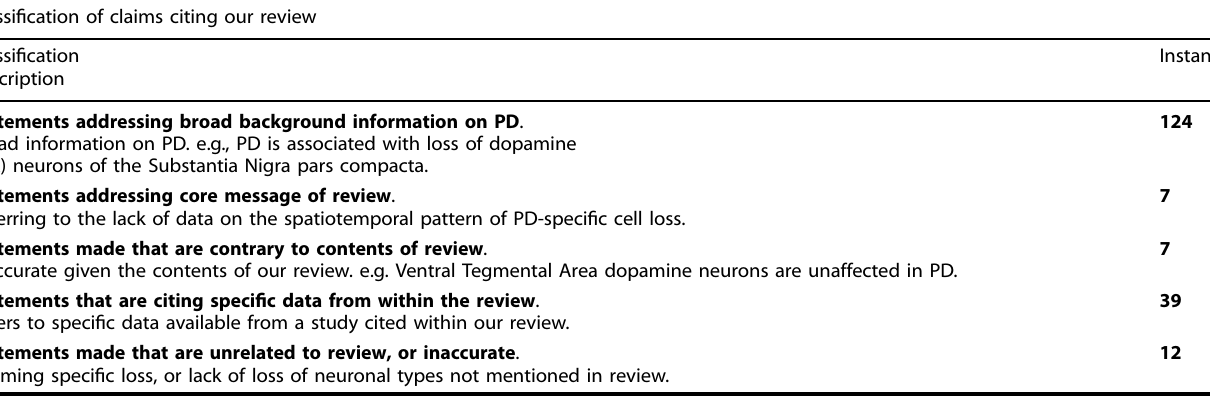
Table 1. Statements made citing our review categorized according to the described